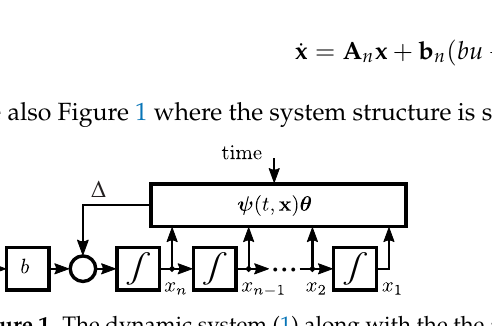
Figure 1. The dynamic system (1) along with the the assumed parametrization